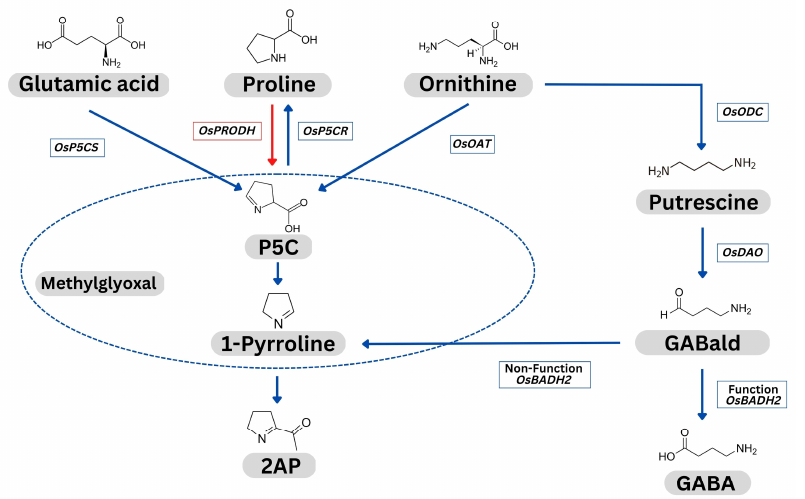
Figure 1. Biosynthesis pathway for 2AP in scented rice varieties. OsP5CS : 1-pyrroline-5 carboxylate synthetase; OsP5CR : pyrroline-5 carboxylate reductase; OsOAT : ornithine aminotransferase; OsPRODH : proline dehydrogenase; OsODC : ornithine decarboxylase; OsDAO : diamine oxidase; P5C: 1-pyrroline-5 carboxylic acid; OsBADH2 : betaine aldehyde dehydrogenase; 2AP: 2-acetyl-1-pyrroline; GABA: γ -aminobutyric acid; GABald: γ -amino butyraldehyde. (Adapted from [24]).